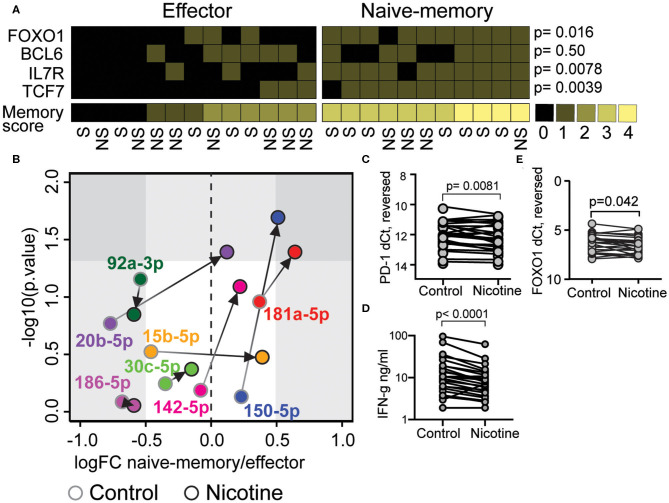
Nicotine stimulation induces micro RNA (miR)-181a-5p and miR-150-5p in CD8+ T cell with a naïve-memory phenotype. Isolated CD8+ T cells from peripheral blood of rheumatoid arthritis patients were cultured for 48 h in presence of aCD3 stimulation. Messenger RNA (mRNA) and miRs were measured by quantitative PCR. (A) A scoring system was constructed to differentiate between naïve-memory and effector phenotype. A higher than median expression of IL7R, FOXO1, BCL6, and TCF7 mRNA were rewarded with one point each. Samples with at least three points were considered to have a naïve-memory phenotype. (B) The fold change (FC) of miRs in samples with naïve-memory vs. effector phenotype. Cells were stimulated with aCD3 alone (gray circles) or with an addition of 10 μM nicotine (black circles). (C,D) PD-1 mRNA (C), FOXO1 mRNA (D), and IFN-γ secretion (E) in cells treated with 10 μM nicotine compared to cells only exposed to αCD3. P-values were calculated with Mann-Whitney U-test or Wilcoxon matched-pairs signed rank test. S, smoker; NS, non-smoker.